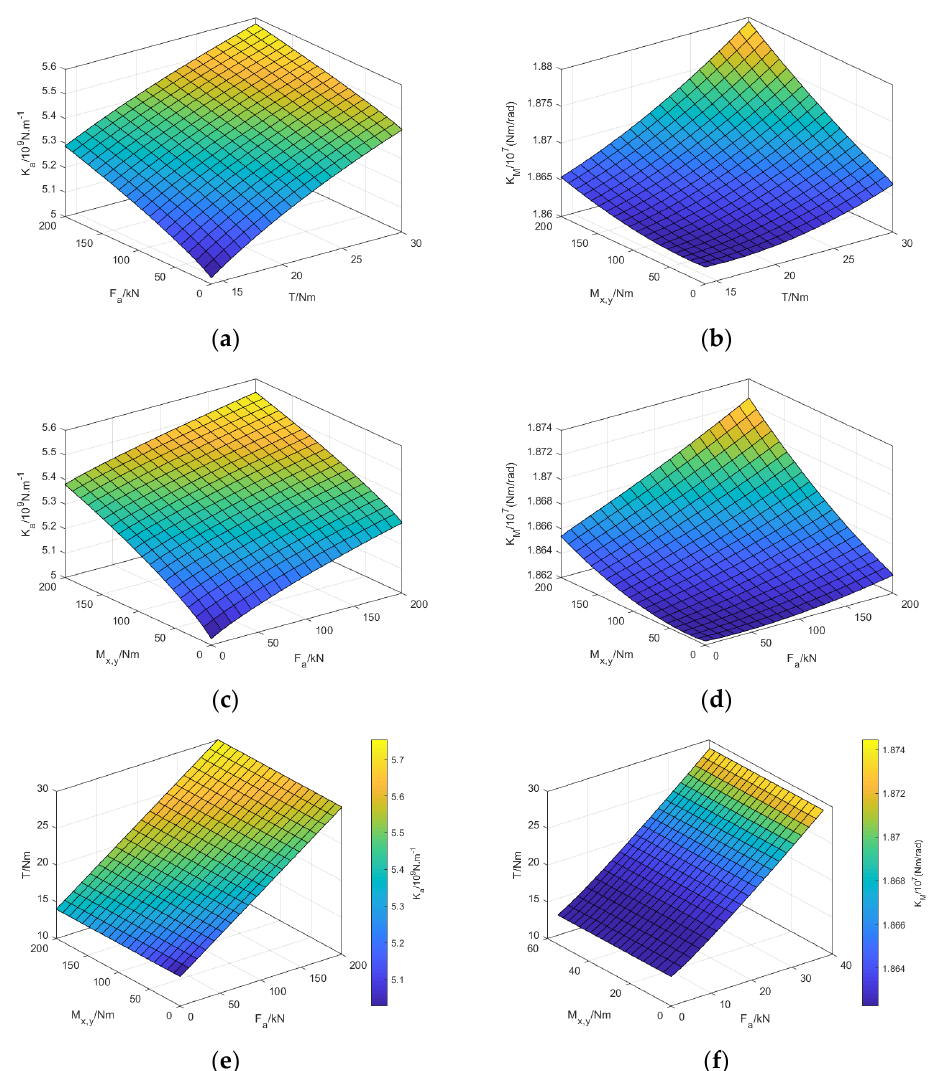
Figure 7. Effect of external load on the bearing stiffness of the turntable; ( a ) Variation of K a with F a and T ; ( b ) Variation of K M with M x,y and T ; ( c ) Variation of K a with F a and M x,y ( T = 14 N · m ) ; ( d ) Variation of K M with F a and M x,y ( T = 14 N · m ) ; ( e ) Variation of K a with F a , M x,y and T ; ( f ) Variation of K M with F a , M x,y and T .